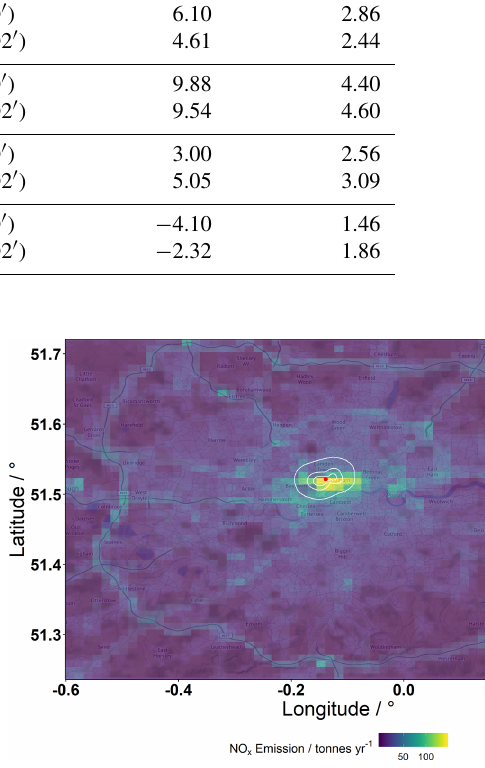
Figure 7. The sum of the NAEI layers corresponding to SNAP sec- tors 07, 02, 03, and 08 (see Table A1) to show the spatial distribu- tion of the majority of NO x emissions in central London. The 30%, 60%, and 90% contributions to the flux footprint climatology for EC measurements made between March and July 2017 are shown in white. The red point shows the location of the BT Tower. Map tiles by Stamen Design, under CC BY 3.0. Data © OpenStreetMap con- tributors 2021. Distributed under the Open Data Commons Open Database License (ODbL) v1.0. Tiles accessed via the ggmap R package (Kahle and Wickham,